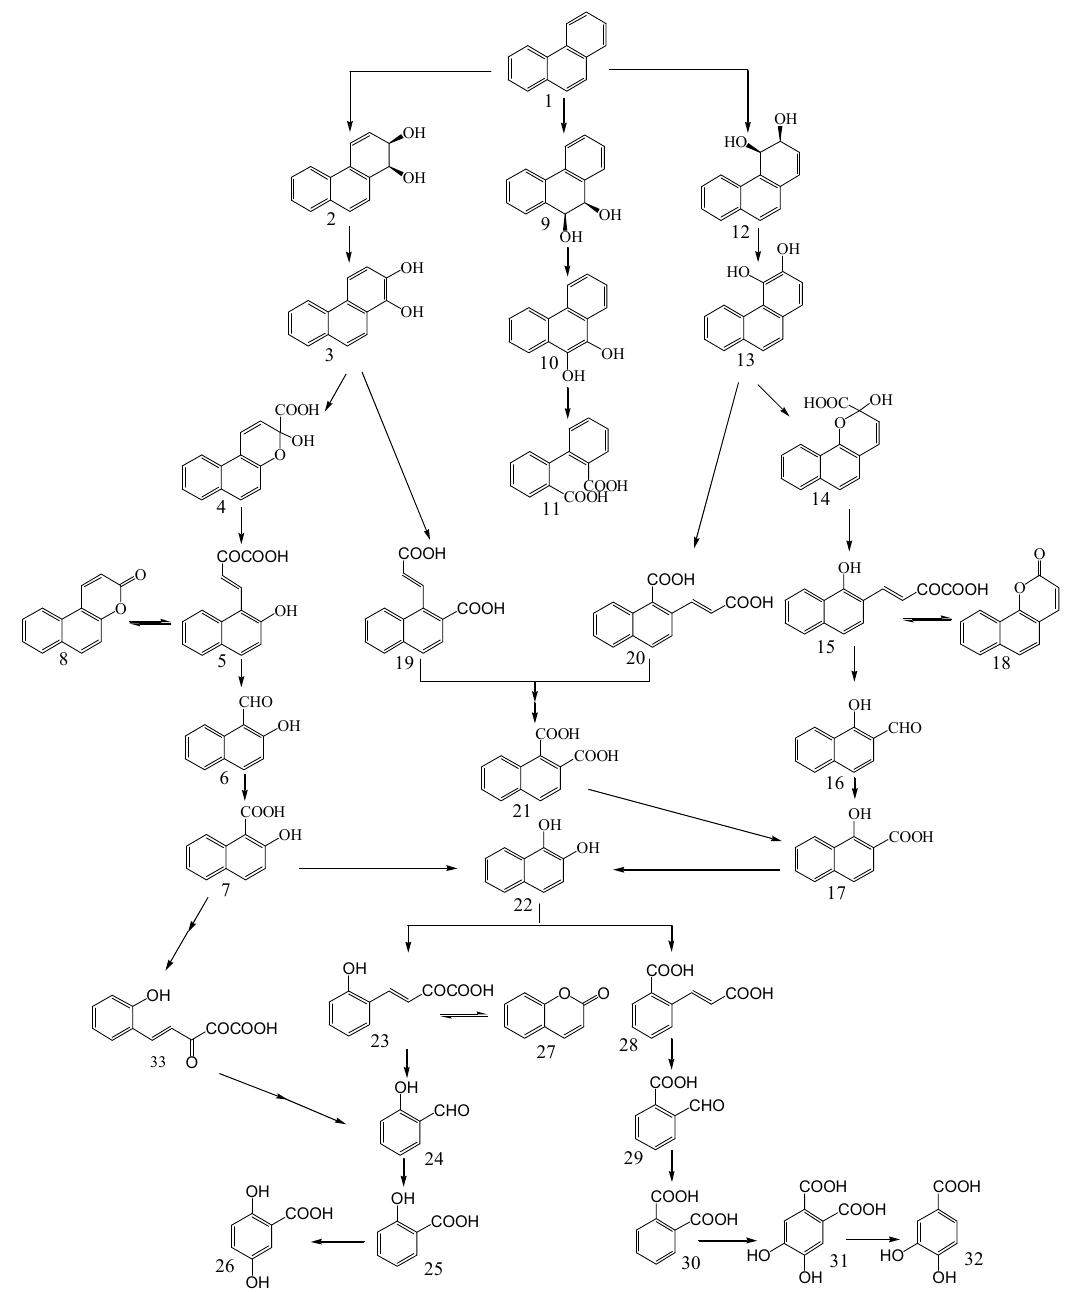
Scheme 3. Proposed catabolic pathways of phenanthrene by bacteria [24, 49, 55, 57, 58, 63, 139,